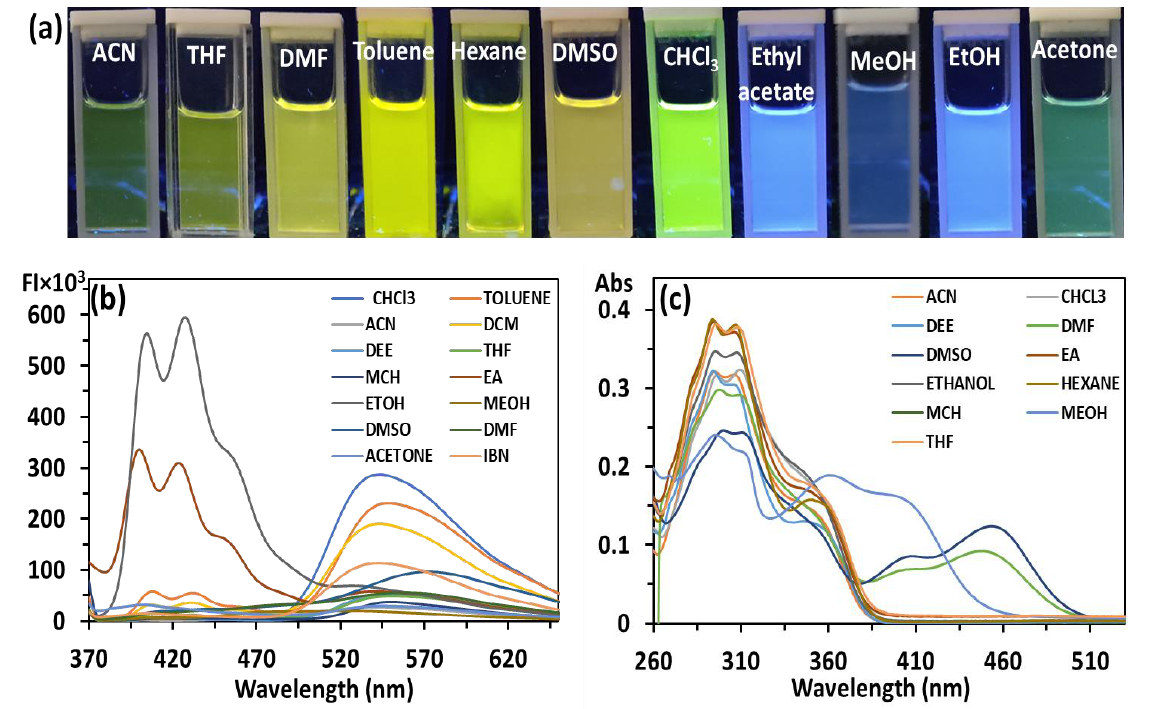
Figure 1. ( a ) Photographs (under 365 nm UV-illumination); ( b ) emission and ( c ) absorbance spectrum of HBT 2 (10 μ M) recorded in various solvents of different polarity. Photographs were taken at concentration 10 μ M of HBT 2 .